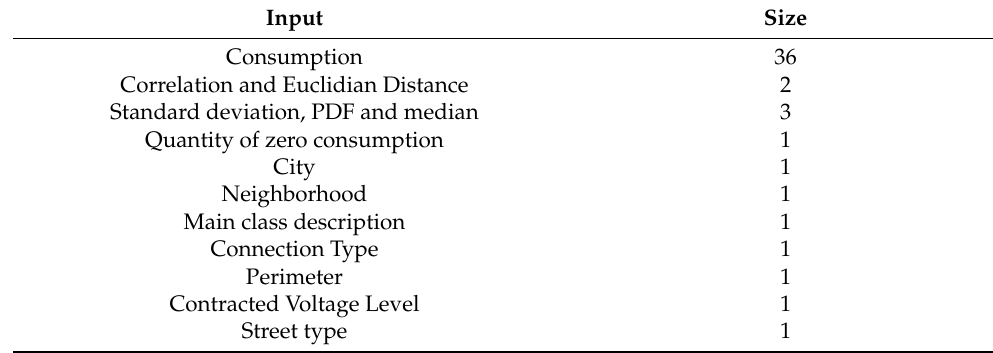
Table 3. Model inputs size.